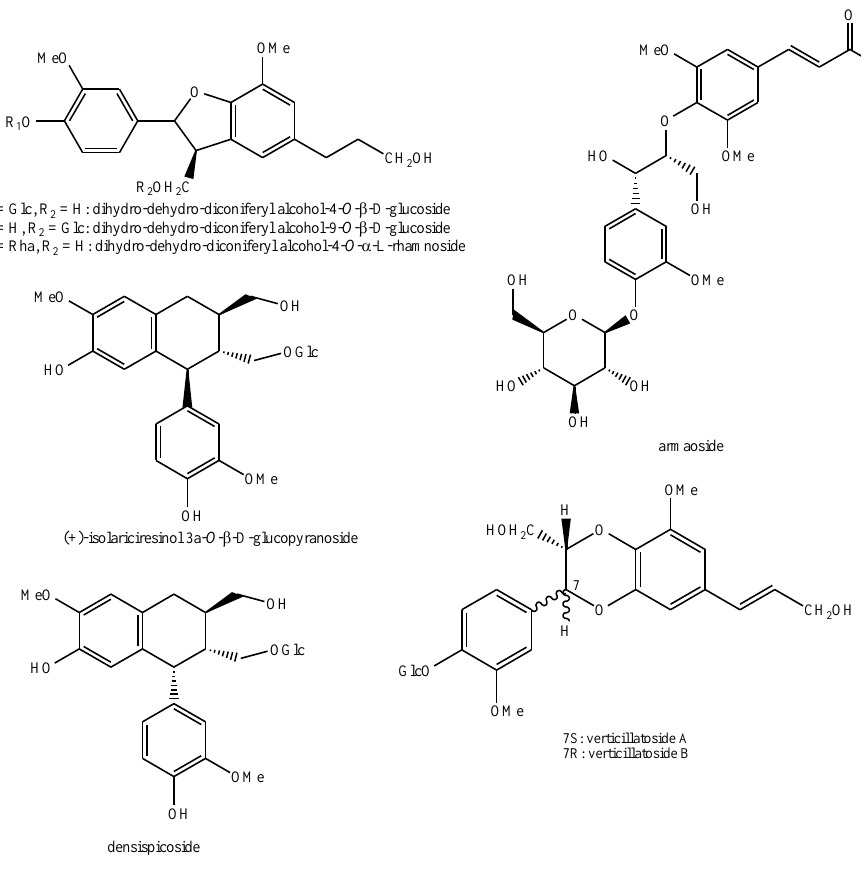
Figure 6. Alkaloids identified in Pedicularis species—part 2.